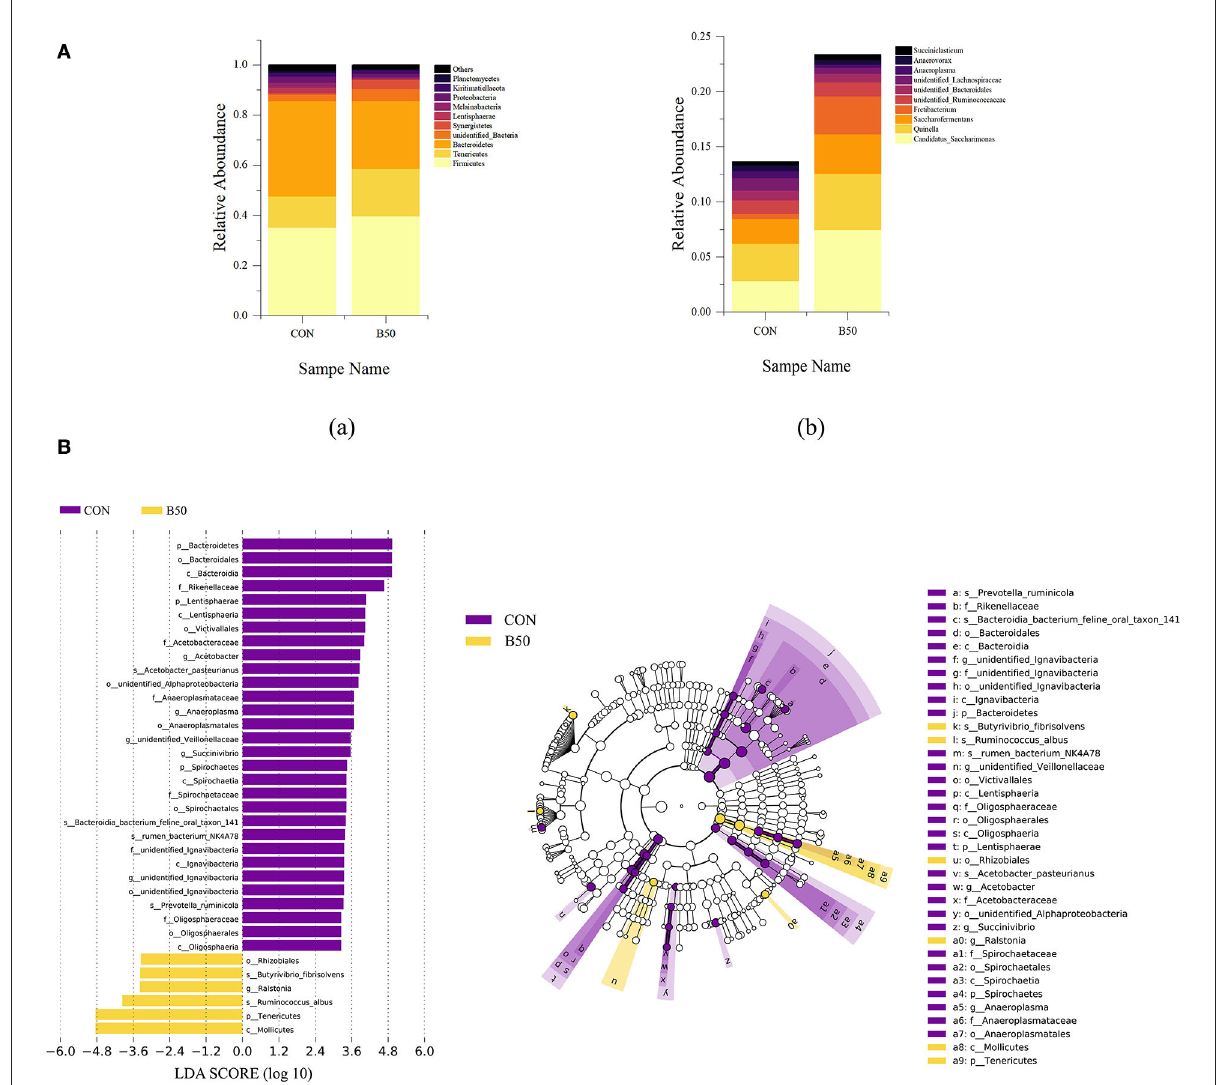
FIGURE6 Composition and LEfSe analyses of rumen fluid microflora. (A) Component of rumen fluid microbiota: (a) phylum level; (b) genus level. (B) LEfSe analysis plot of rumen fluid